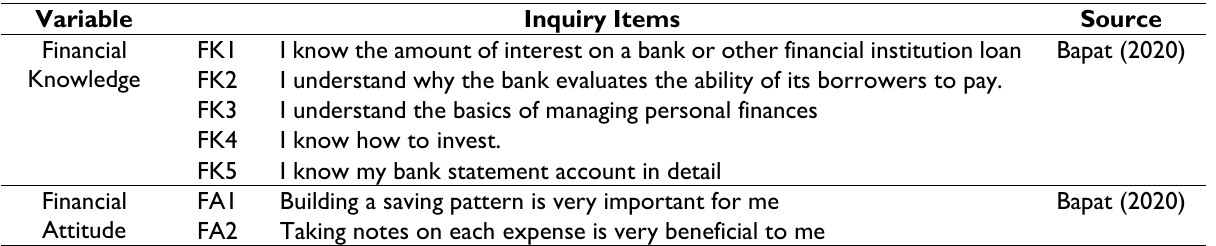
Table 1. Operational Definition of the